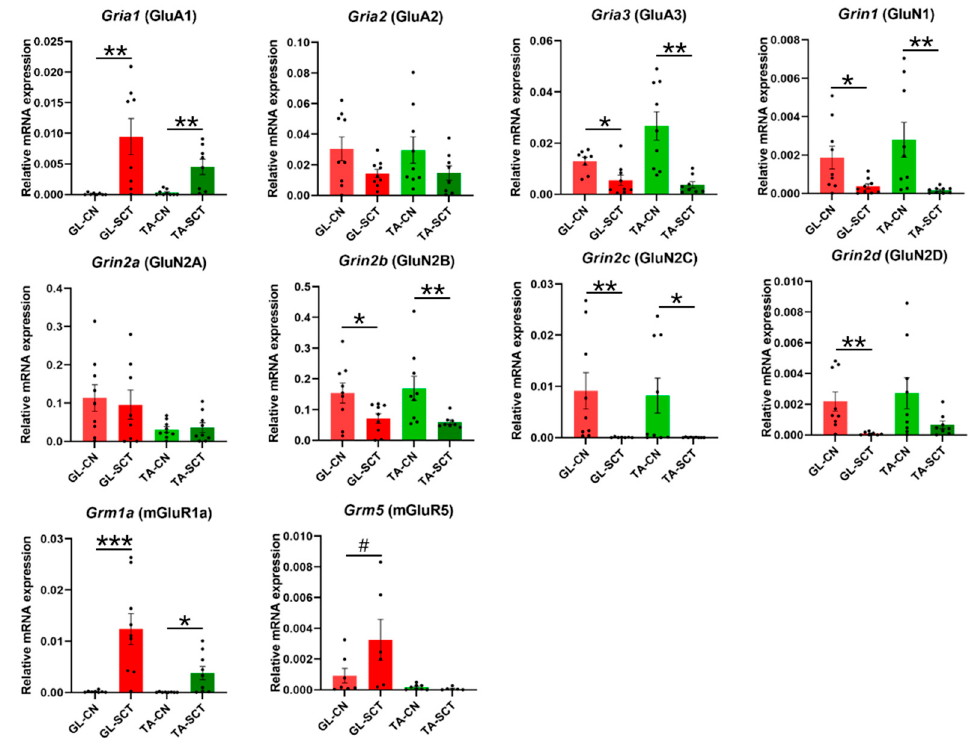
Figure 3. SCT differentially affects the transcript levels of AMPAR, NMDAR, and mGluRs subunits, with the same impact on GL and TA MNs. SCT led to a significant increase in the Gria1 (GluA1) subunit and a decrease in the Gria3 (GluA3) subunit. A significant decrease in transcripts of all subunits of NMDAR except for Grin2a (GluN2A) was found. Upregulation of the transcript level of Grm1a (mGluR1A) in GL and TA MNs was accompanied by an increase in the transcript level of Grm5 (mGluR5) in GL MNs but not in TA MNs. Data are means +/ − SEM. Mann-Whitney U -test, # p = 0.074; * p < 0.05; ** p < 0.01; *** p < 0.001.